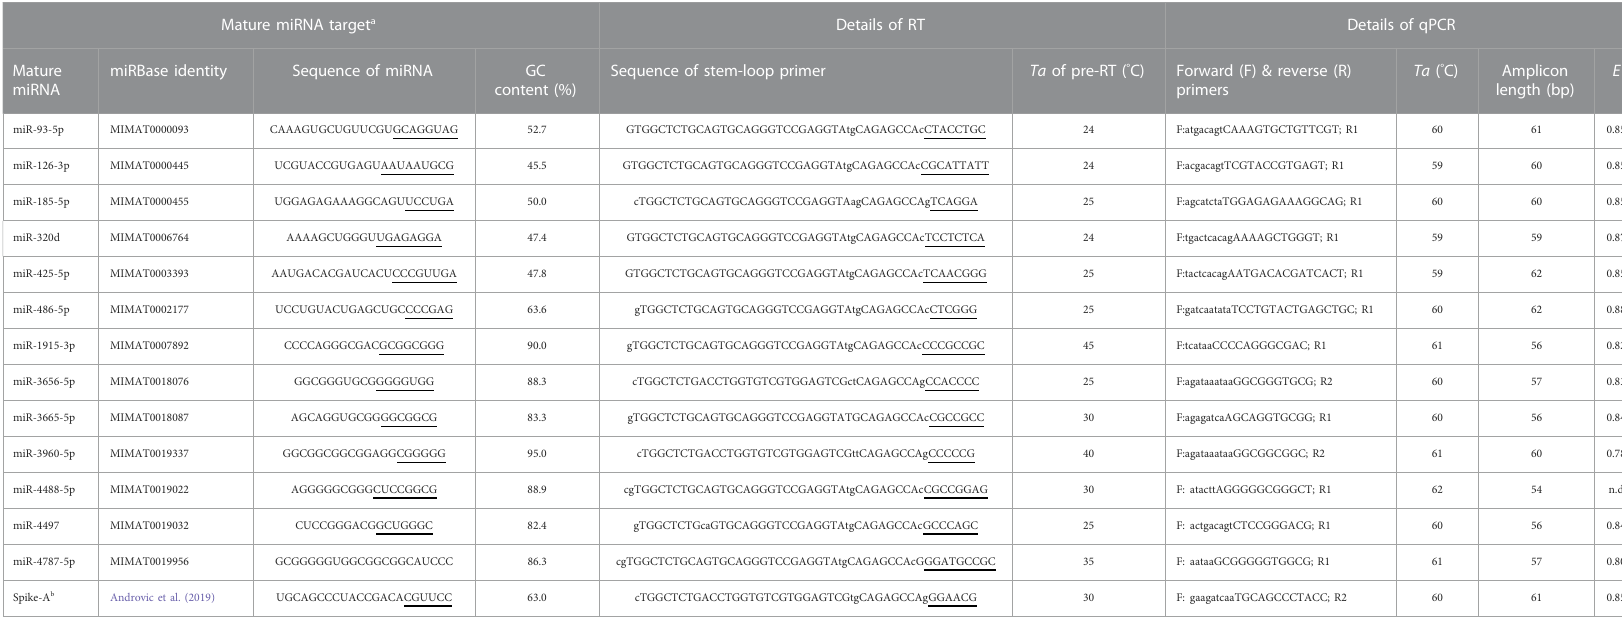
TABLE 2 Details of stem-loop RT-qPCR